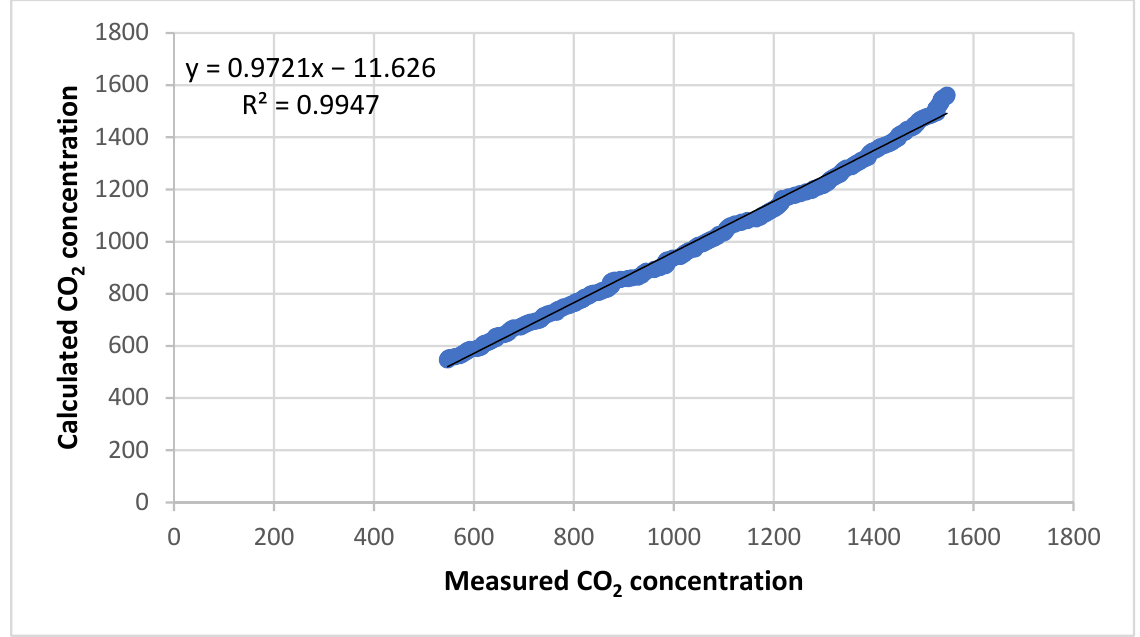
Figure 16. Rate of increase in CO 2 concentration.